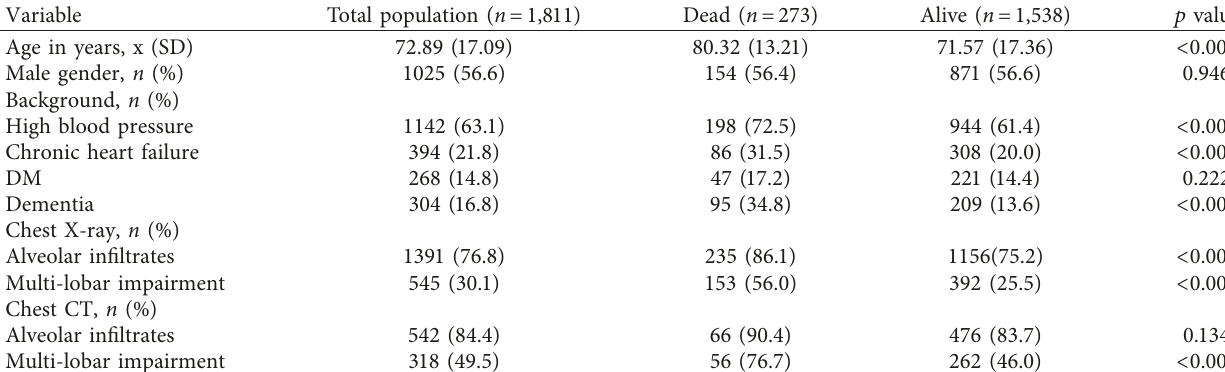
Table 1: General characteristics of the population.